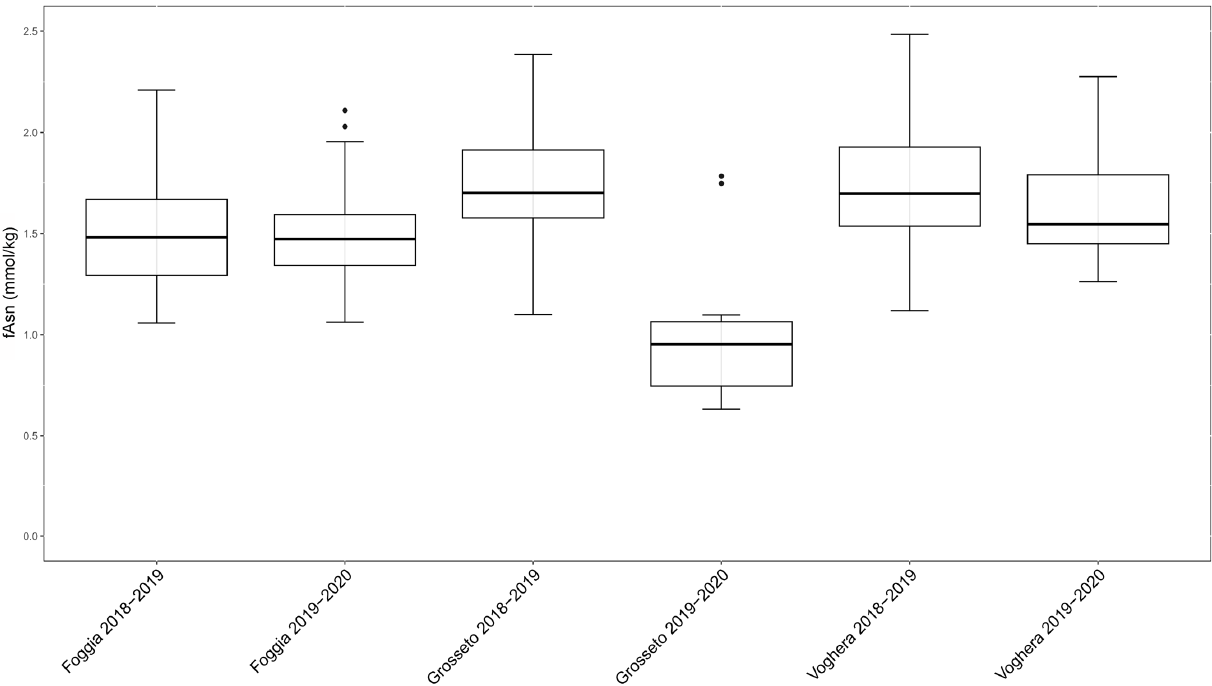
Figure 3. Box plots of fAsn measurements in the six considered field trials, considering the data from the 18 genotypes common to the six field trials. the 18 genotypes common to the six field